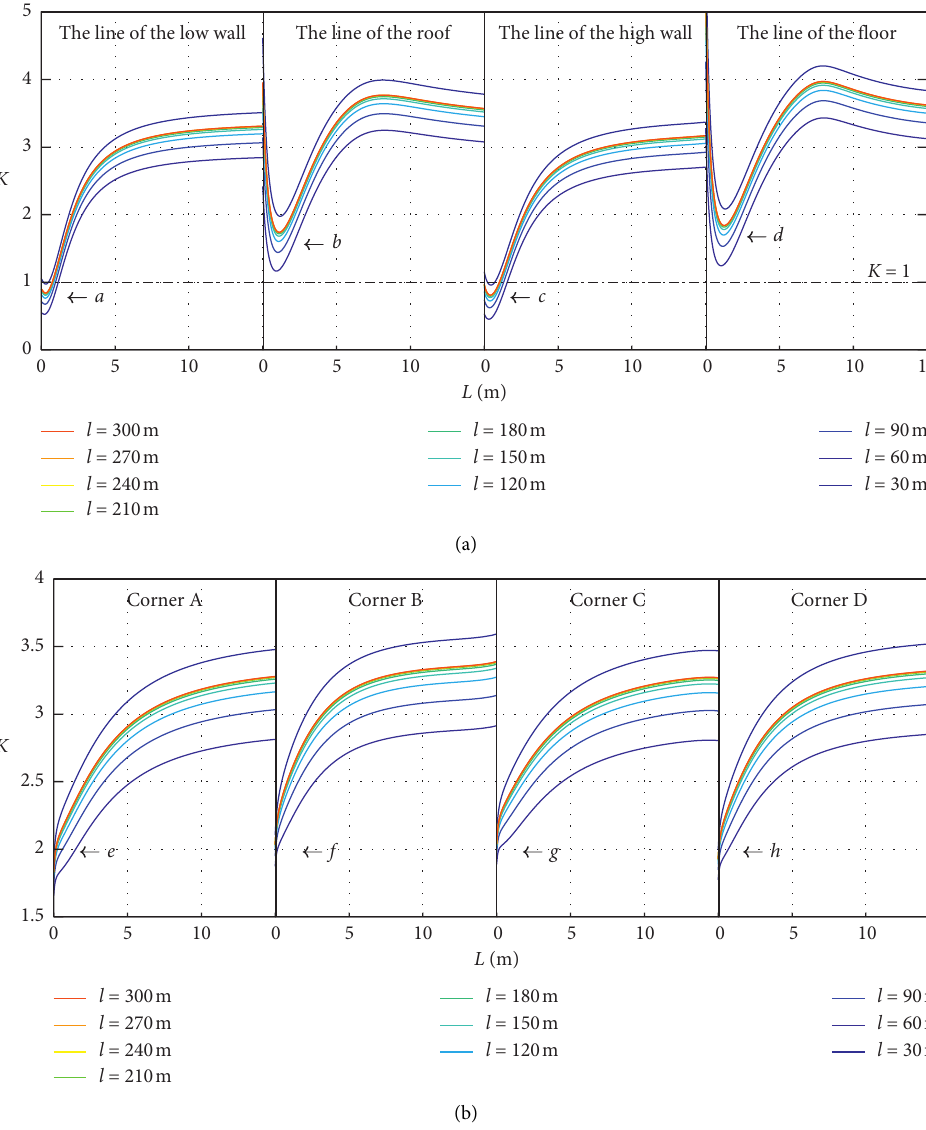
Figure 6: SRSI curve at the radial survey line of IRMR at different distances from working face. (a) The survey line of the rock wall. (b) The survey line of the